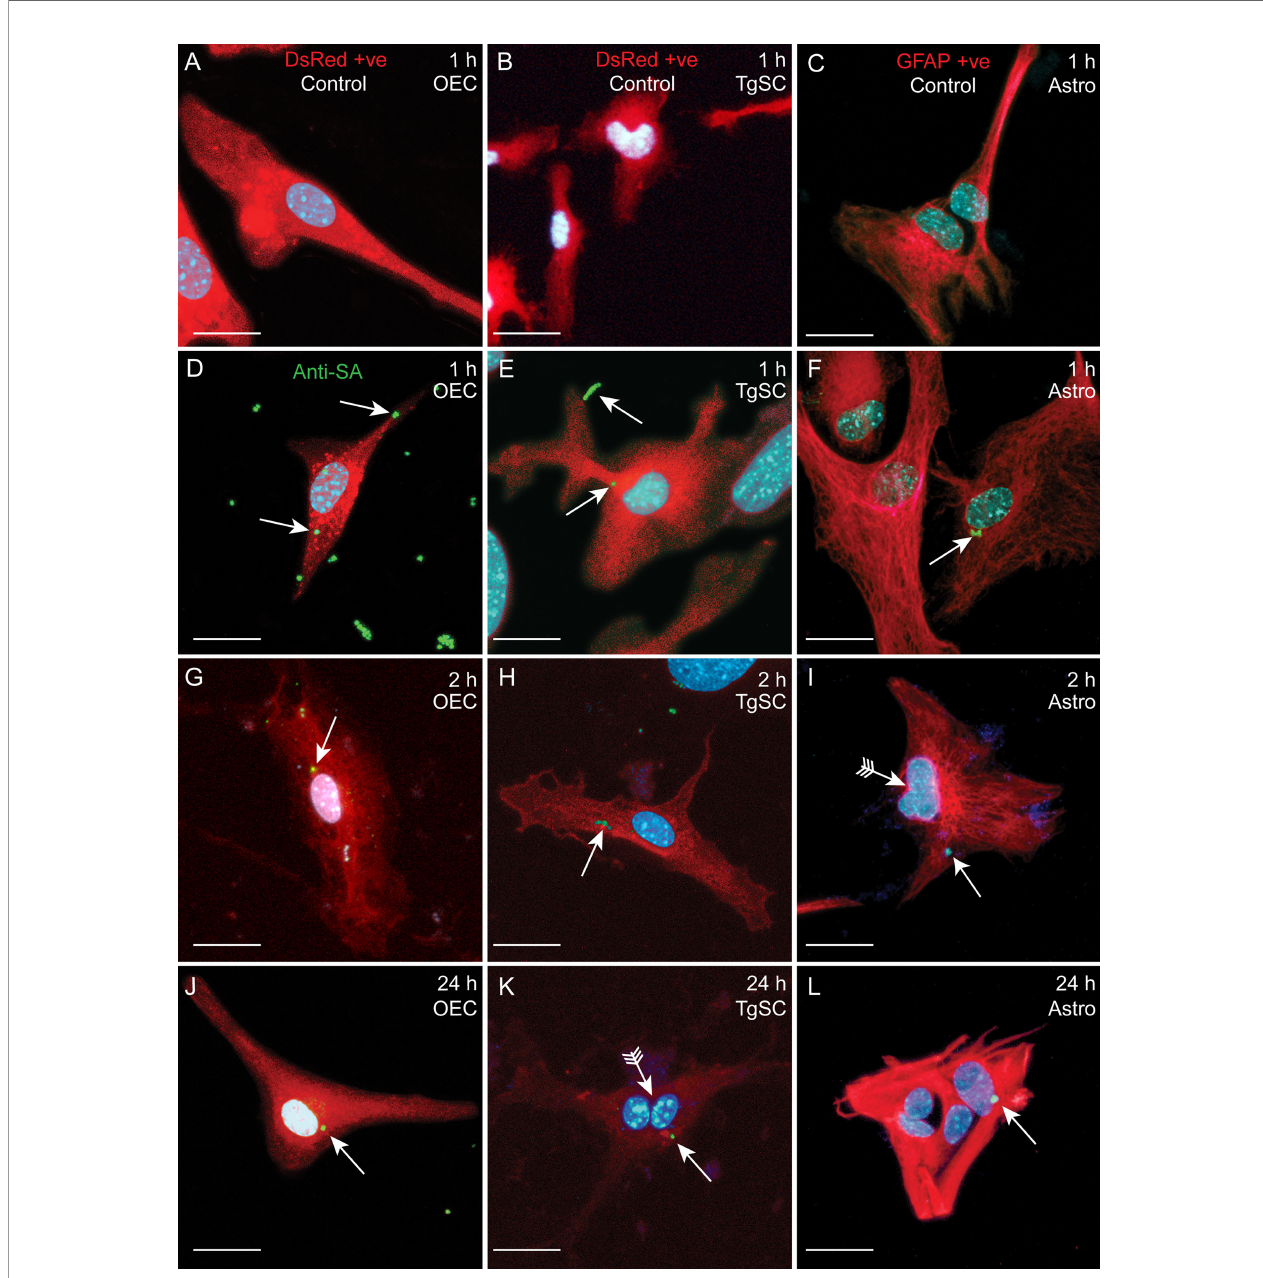
FIGURE 4 | Confocal images showing attachment and internalisation of S. agalactiae in glia (OECs, TgSCs and astrocytes). (A – C) Control cells (without S. agalactiae ). OECs and TgSCs were visualised by DsRed expression (red), whilst astrocytes were immunolabelled for GFAP (red). Nuclei are stained with DAPI (blue). (D – L) Representative images of OECs, TgSCs and astrocytes following inoculation with S. agalactiae (anti- S. agalactiae antibody (anti-SA); green, arrow). After 1 h of exposure to S. agalactiae (D – F) , extracellular bacteria were removed by washing and addition of antibiotic in the medium. S. agalactiae were detected in the glia at 2 h (G – I) and at 24 h post infection (J – L) . Some cells exhibited atypical nuclei or binucleation (arrows with tail). Scale bar: 20 m